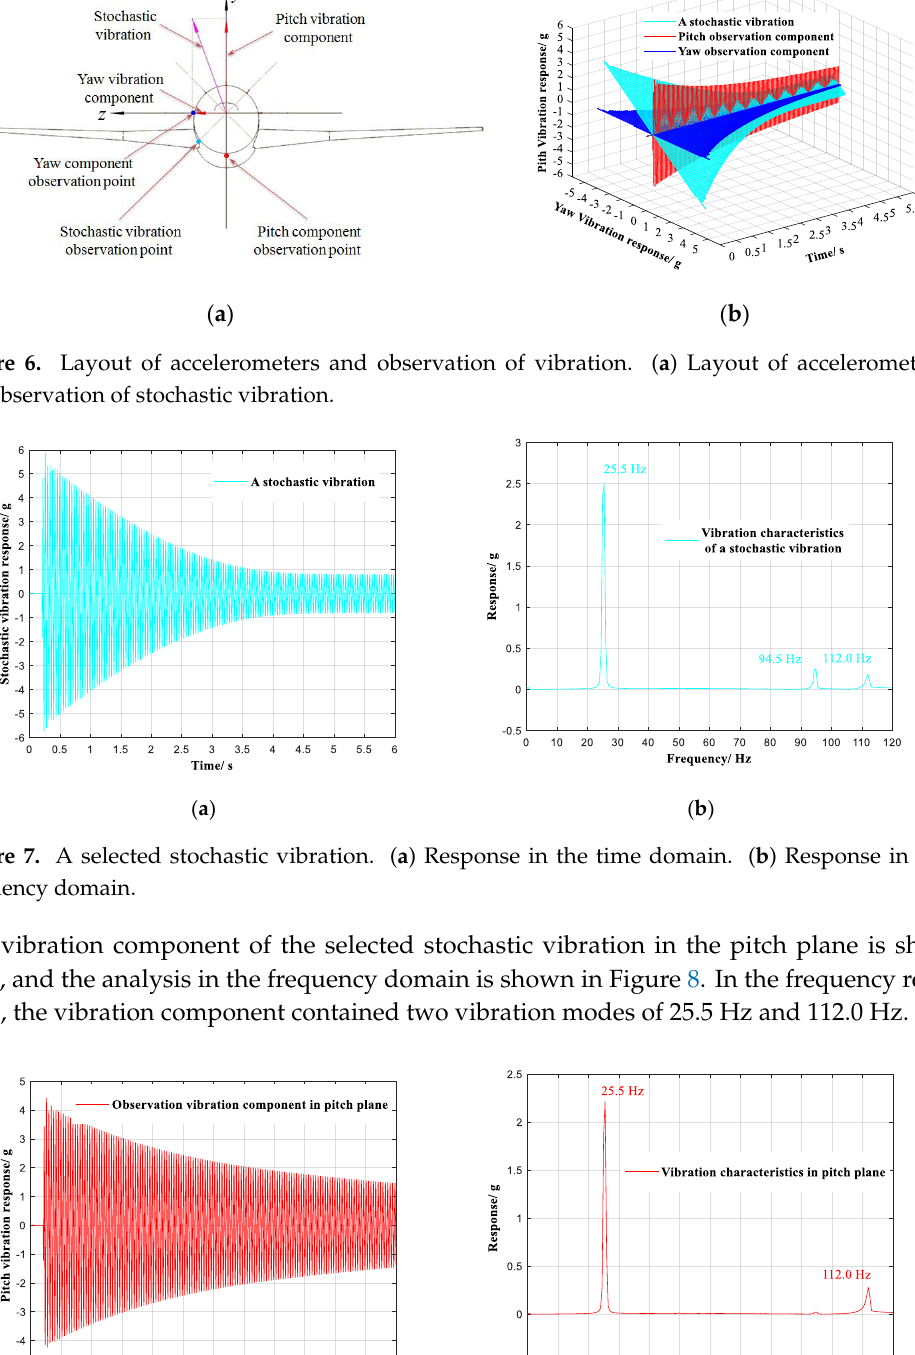
Figure 8. Vibration component of the selected stochastic vibration in the pitch plane. ( a ) Response in the time domain. ( b ) Response in the frequency domain.